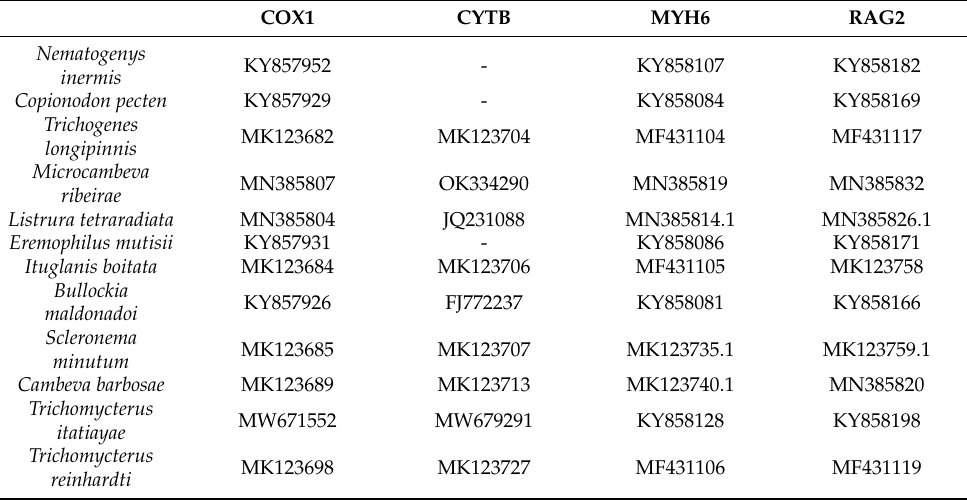
Table A1. Terminal taxa for molecular phylogeny and respective GenBank accession